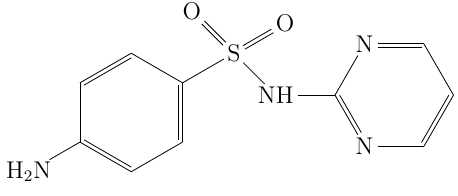
Figure 1. Molecular structure of the